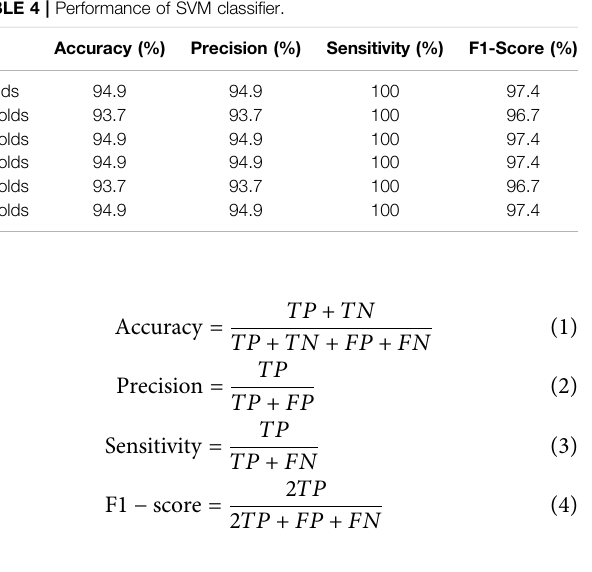
TABLE 4 | Performance of SVM classi fi